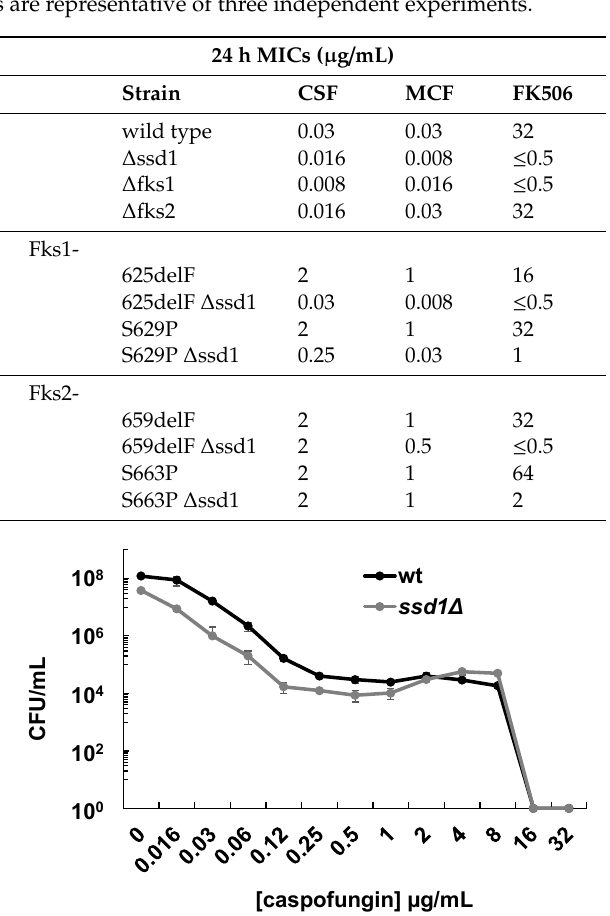
Table 1. Disruption of SSD1 selectively reverses FKS1 -mediated echinocandin resistance and induces FK506 sensitivity. SSD1 was disrupted in wild type and equivalent FKS1 and FKS2 mutants and caspofungin (CSF), micafungin (MCF), and FK506 minimum inhibitory concentrations (MICs) determined. Results are representative of three independent experiments.